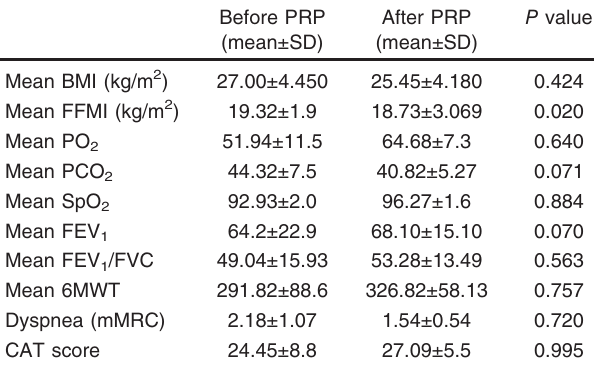
Table 2 Statistical comparison between different variables in the nonmuscle depleted group before and after pulmonary rehabilitation